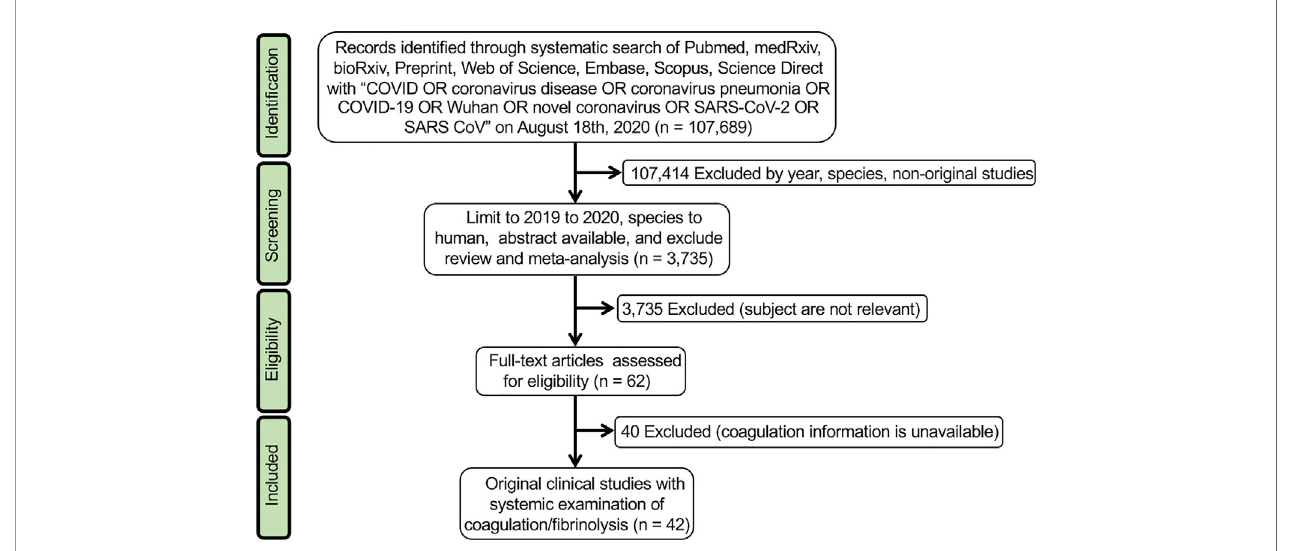
FIGURE 1 | PRISMA 2009 fl ow diagram for searching included